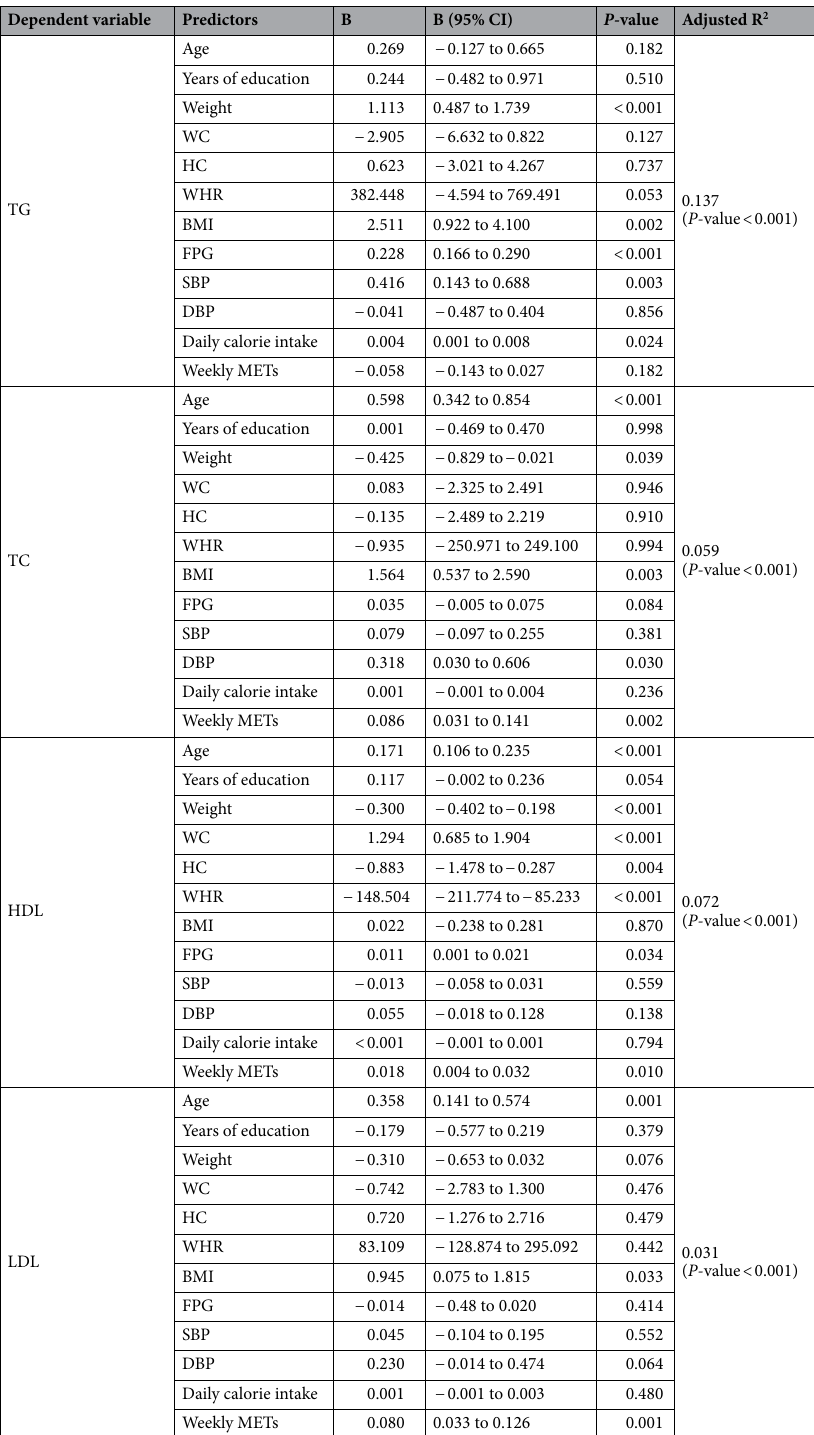
Table 4. Multiple regression analysis of predictors of lipid profile components. TG, triglyceride; TC, total cholesterol; HDL, high-density lipoprotein; LDL, low-density lipoprotein; WC, waist circumference; HC, hip circumference; WHR, waist-to-hip ratio; BMI, body mass index; FPG, fasting plasma glucose; SBP, systolic blood pressure; DBP, diastolic blood pressure; MET, metabolic equivalent of task; CI, confidence